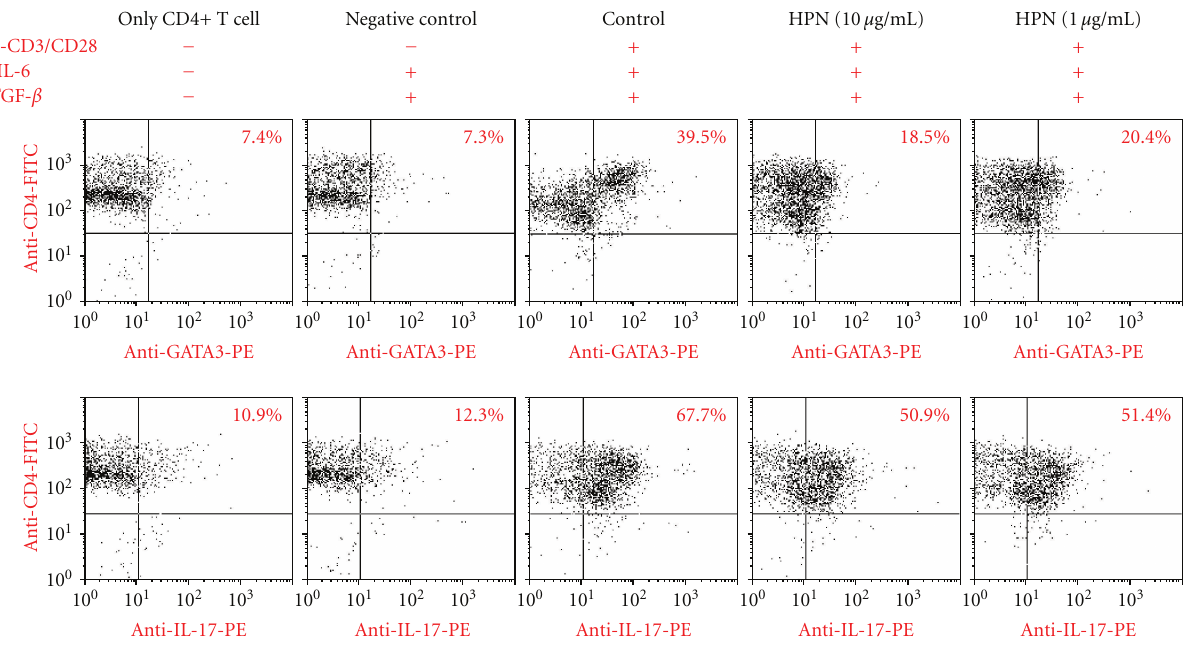
Figure 4: Dot plot pattern of intracellular cytokine staining. X -axis: PE intensity of GATA-3 and IL-17. Y -axis: FITC intensity of CD4. Isolated CD4+ T cells were cultured without (normal group) or with (stimulated group) anti-CD3, anti-CD28, rIL-6, TGF-beta, and with HPN (10, 1 μ g/mL) added to RPMI medium and stained with FITC-conjugated mAb to CD4 and PE-conjugated mAb to GATA-3 or IL-17 (described in Section